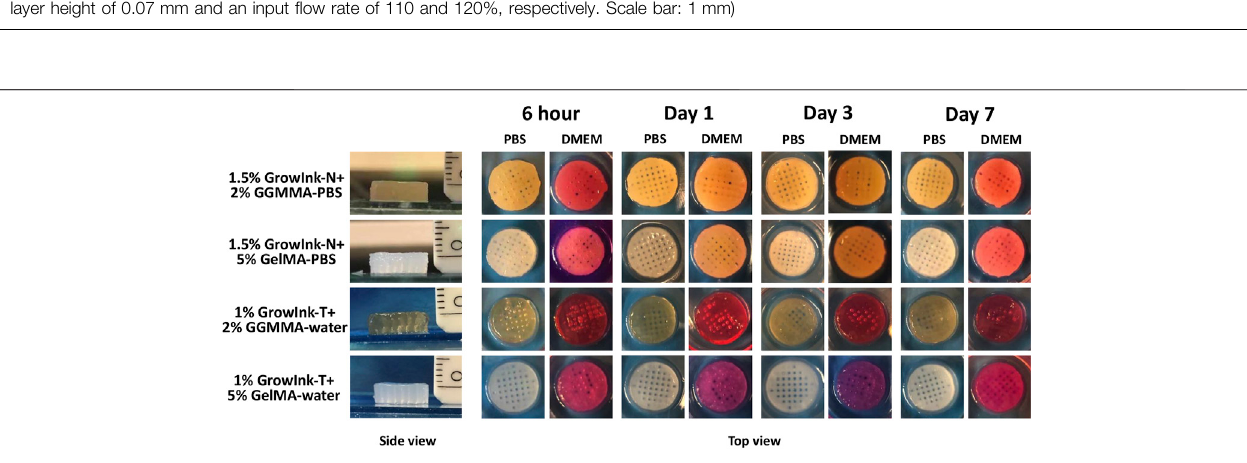
Frontiers in Chemical Engineering |